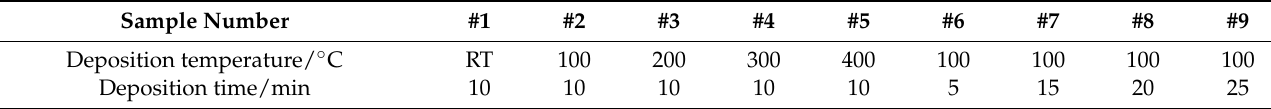
Figure 1. Schematic diagram of the Al film prepared by magnetron sputtering. Table 1. Detail deposition parameters of the Al